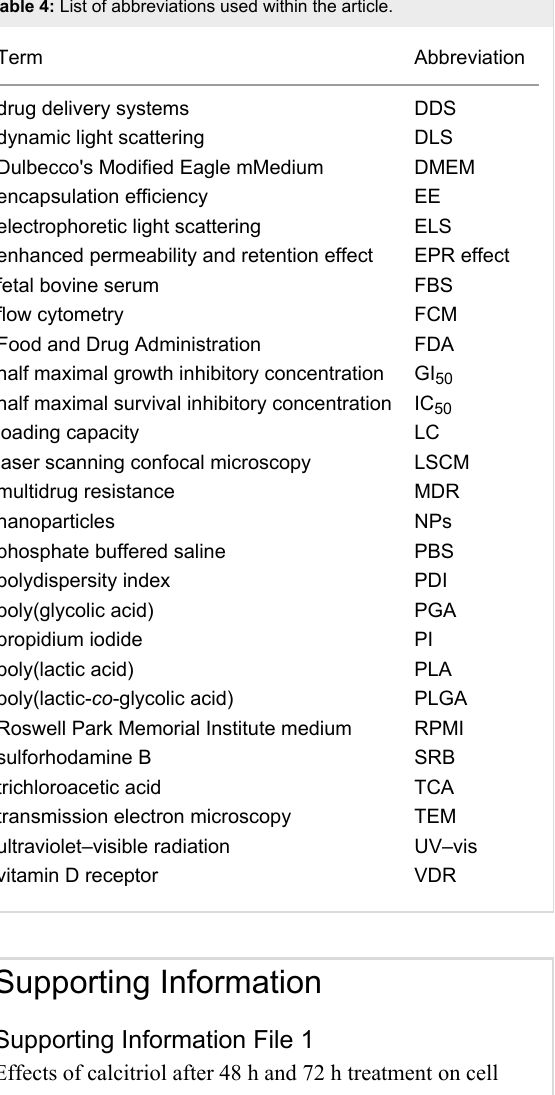
Table 4: List of abbreviations used within the